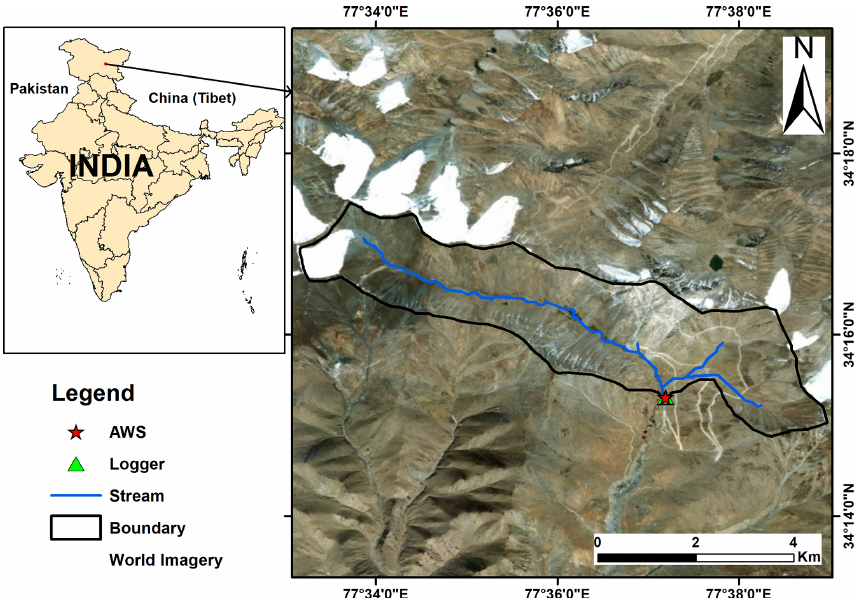
Figure 1. Location of the study site in the upper Ganglass catchment. (Base image sources for the right panel: © Esri, DigitalGlobe, GeoEye, Earthstar Geographic’s, CNES/Airbus DS, USDA, USGS, AEX, Getmapping, Aerogrid, IGN, IGP, swisstopo and the GIS user community). Please note that the above figure contains disputed